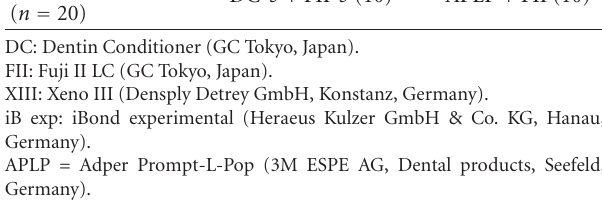
Table 1: Pretreatment and bonding procedures for the 3 groups tested. Group Buccal Cavity ( n ) Lingual Cavity ( n ) (Number of cavities) Group I